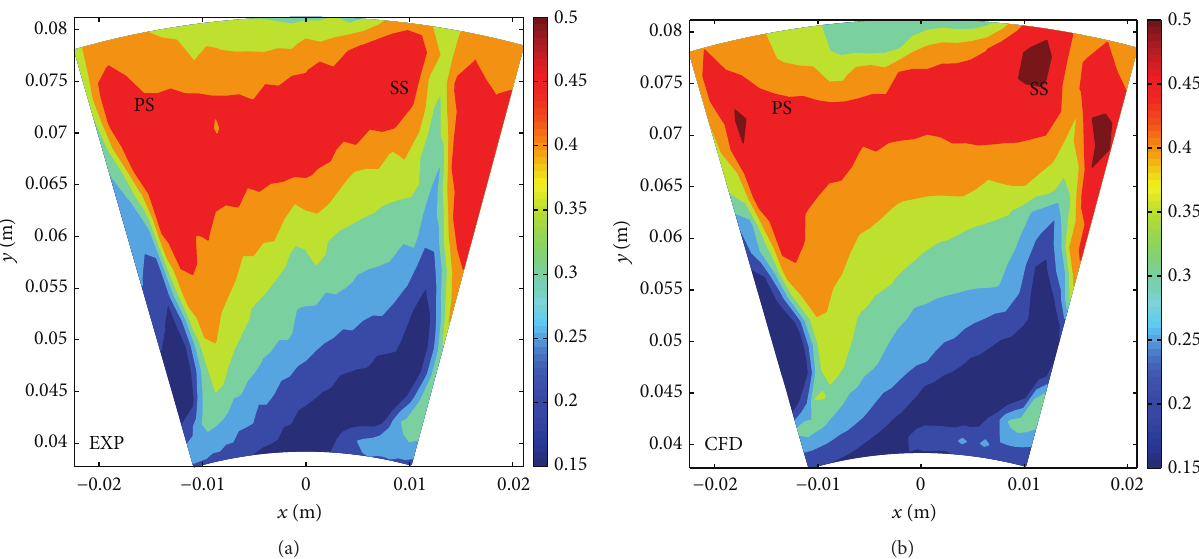
Figure 10: Comparison of measured (a) versus predicted (b) nondimensional stagnation pressure contours downstream of the axial stator over 1.12-blade pitch at point 9 in Figure 7.